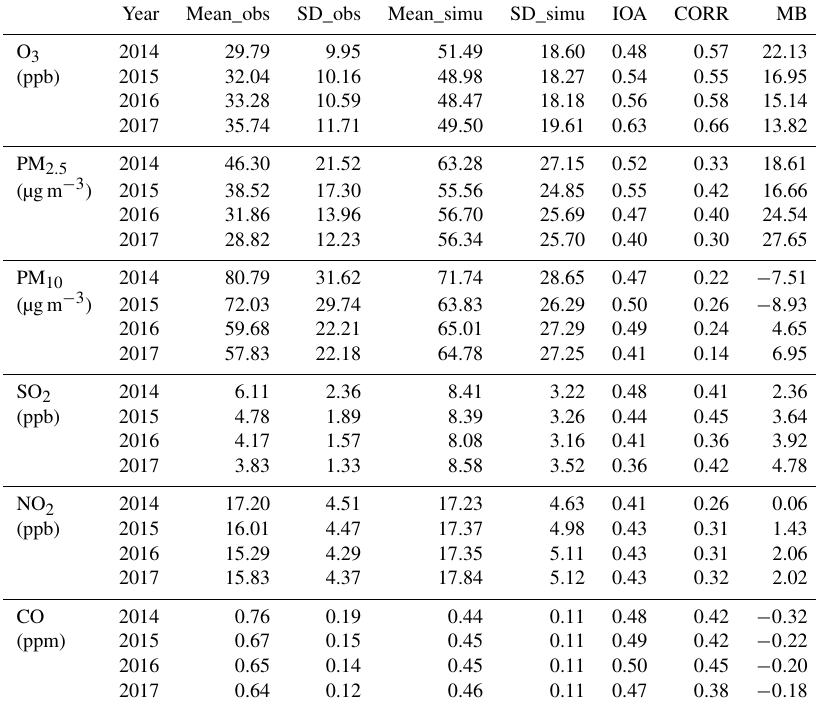
Table 5. Evaluation results for the air pollutants in China. Mean_obs (Mean_simu) is the mean value of observation (model simulation); SD_obs (SD_simu) is the standard deviation of the observation (model simulation); IOA is the index of agreement; CORR is the correlation coefficient; MB is the mean